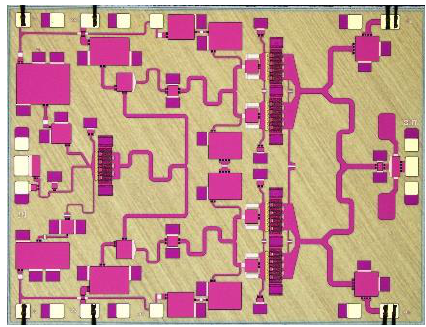
Figure 12. Photograph of the proposed X-band power amplifier.